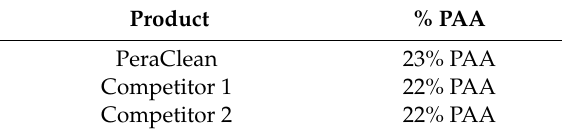
Table 1. The PAA concentrations of the products as described by the chemistry